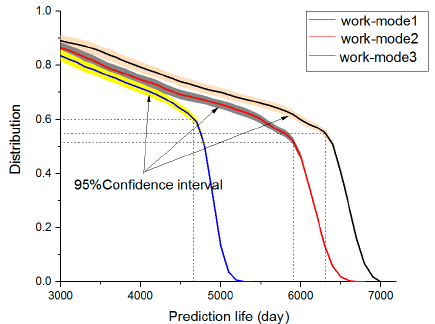
Figure 21. Life distribution of the FS with Configuration 1 in di ff erent work modes.